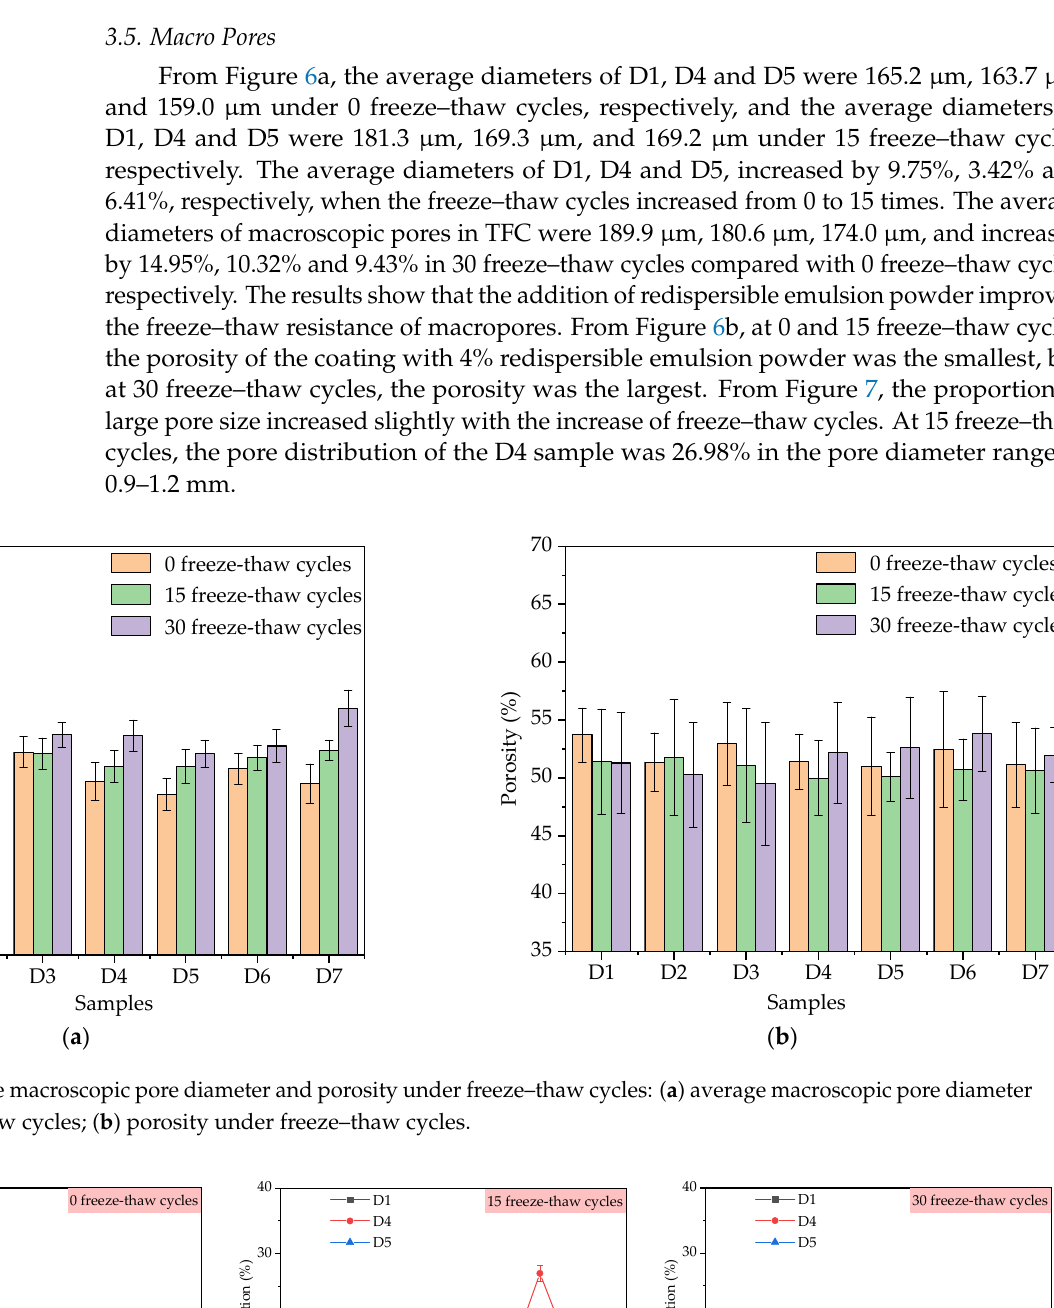
( c ) Figure 8. Pore distribution under the influence of polypropylene fiber: ( a ) 0 freeze-thaw cycles; ( b ) 15 freeze-thaw cycles; ( c ) 30 freeze-thaw cycles.